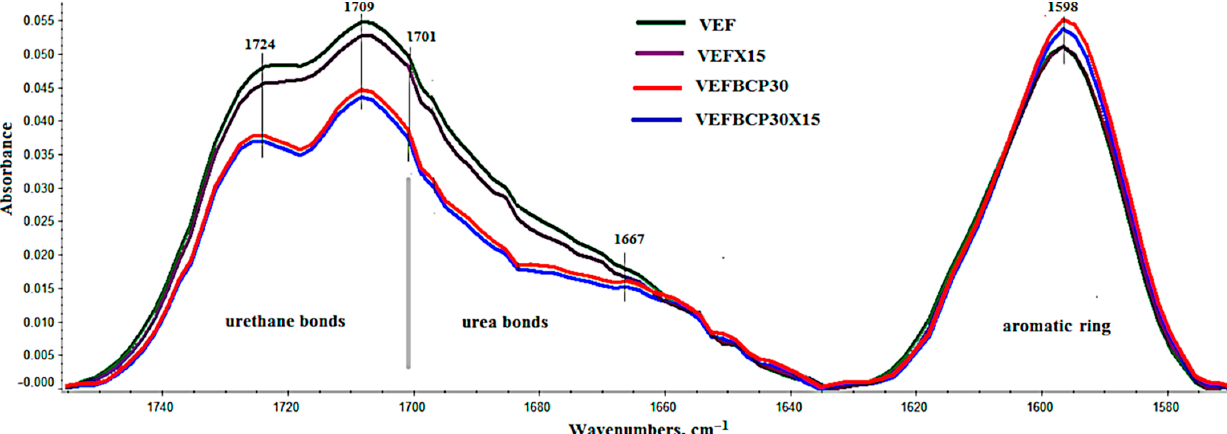
Figure 3. Region of C=O of FT-IR spectra of unmodified foams (VEF) and modified with 15 php of graphite 399 (VEFX15), with 30 php of blackcurrant pomace (VEFBCP30) and the mixture of graphite 399 and blackcurrant pomace (BCP) (VEF- BCP30X15).